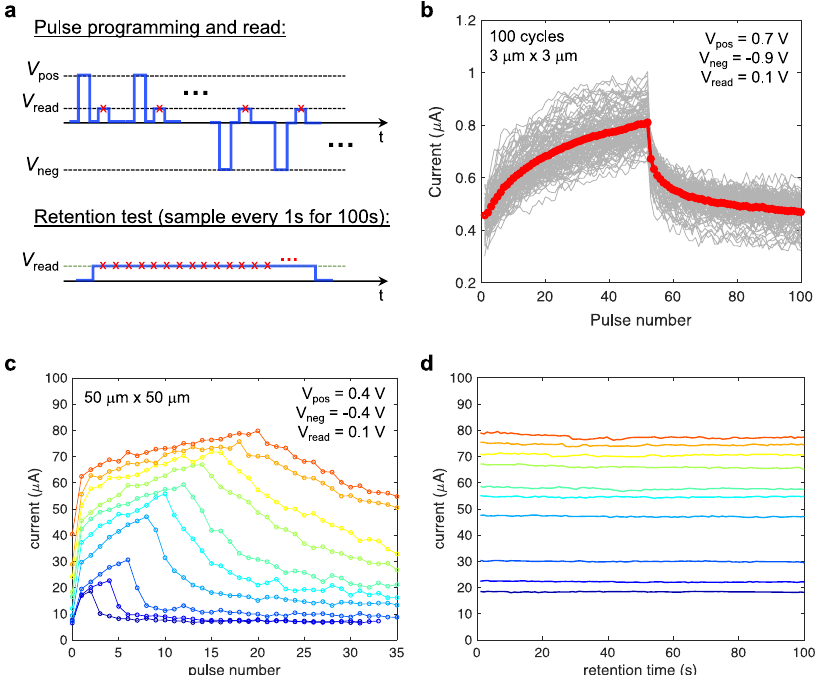
Fig. 3 Multi-state non-volatile pulse programming of h-BN memristors. a Diagram of the pulsed measurements and retention test. b 100 cycles of pulse programming for Au/h-BN/Ti memristor with 3 µm × 3 µm active area (50 positive pulses, followed by 50 negative pulses for each cycle). Gray lines show 100 individual cycles, and the red line shows the average. c Pulse measurement cycles with increasing number of positive pulses. Deep blue to red colored curves corresponds to increasing the number of positive pulses from 2 up to 20. d Retention tests measured immediately after the last positive pulse for each cycle using a read voltage of V read = 0.1 V. The color of the curves in d match the color of the corresponding cycle in ( c